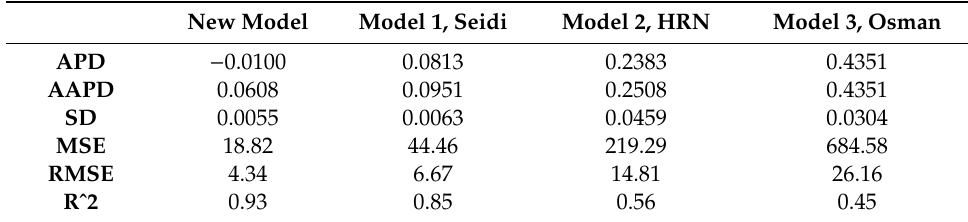
Table 9. A comparison of six di ff erent measures of accuracy corresponding to di ff erent models using production data set of the 128 / 64 inch choke size.